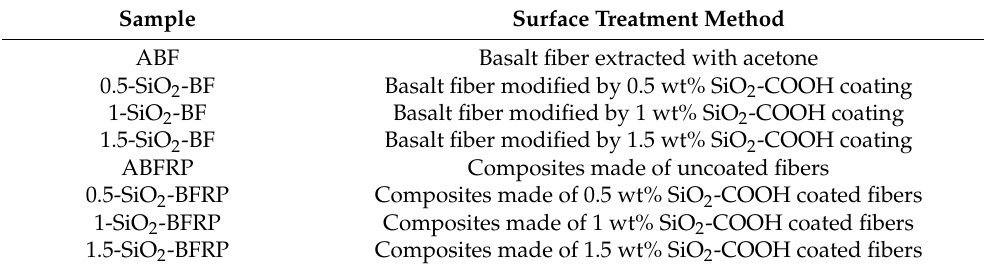
Table 2. Sample abbreviations and treatment